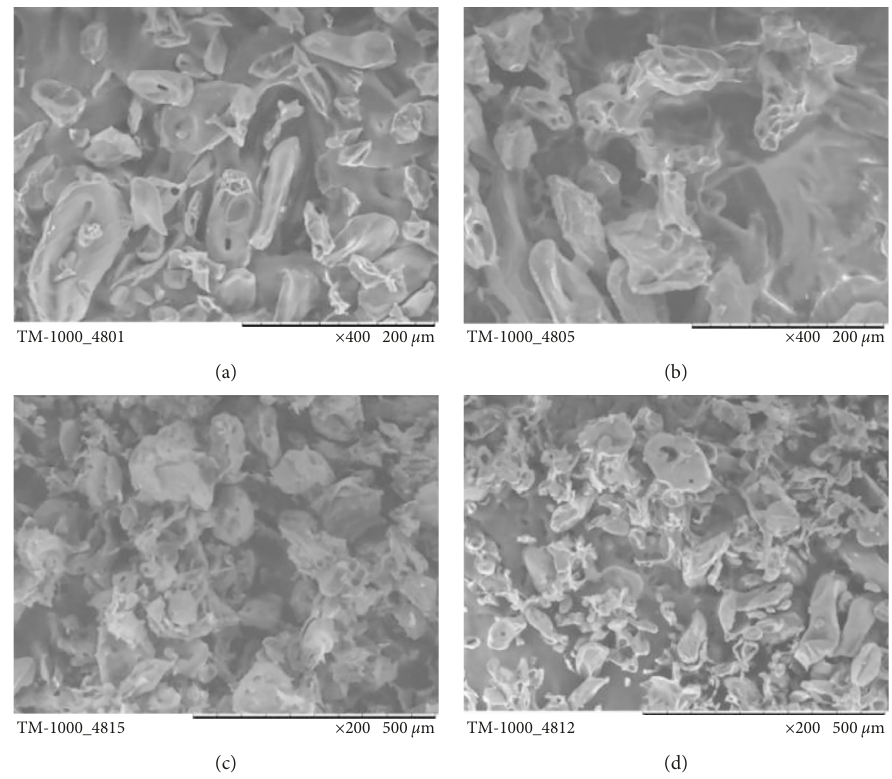
Figure 7: SEM micrographs of hydrogel samples made of CMS 3.2% by (a) ionotropic gelation with CaCl with CaCl 2 4.9% w/v, (c) polyelectrolyte complexation with CS 0.01% w/v, and (d) ionotropic gelation and polyelectrolyte complexation (CaCl 2 1% w/w). Scale (a, b) 400x and (c, d) 200x.